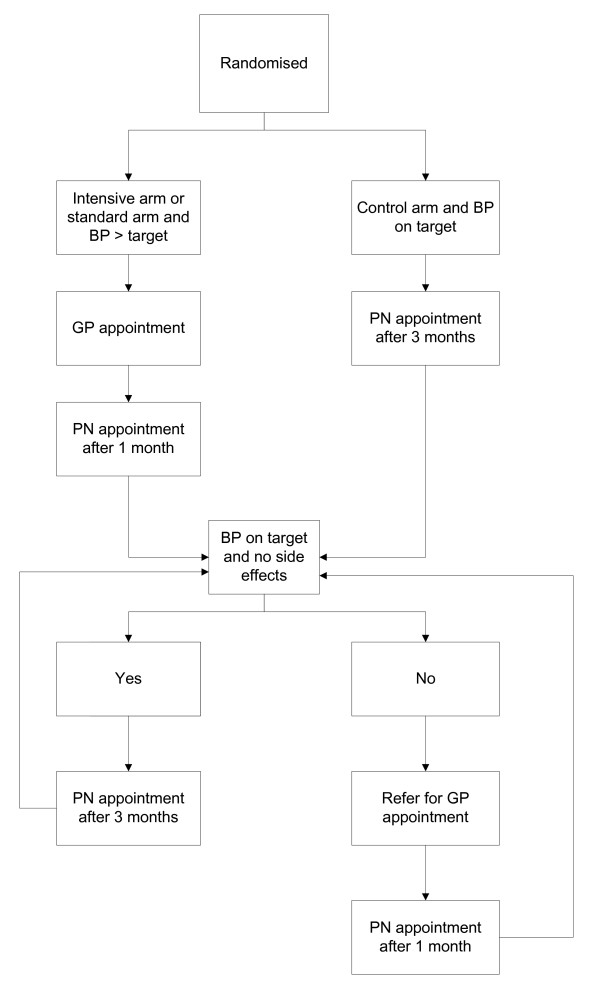
follow up procedure.